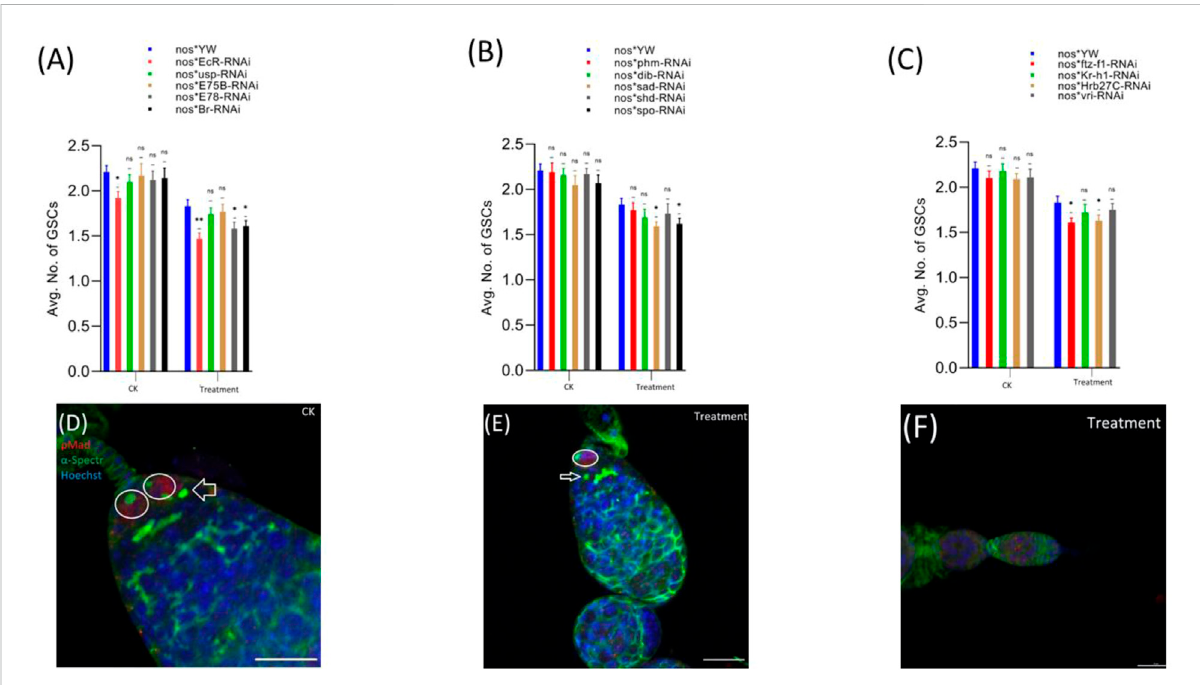
FIGURE 3 Effect of cyromazine on the GSCs of adult ovaries. (A) RNAi of ecdysone-responsive primary genes and the effect of cyromazine on the GSCs. (B) RNAiofHalloweengenesandtheeffectofcyromazineontheGSCs. (C) RNAiofecdysone-responsivegenesandtheeffectofcyromazine onthe GSCs. CK means that the fl ies were fed on a normal diet, while treatment means the fl ies were fed insecticide containing diet. (D) The adult ovariole fromtheCK group.White circleindicatesGSCs,whilewhite arrowrepresentsCBs. (E) Onlyone GSCsandone CBispresentinthecyromazine- treated ovariole. (F) The ovariole lacking any GSC in the germarium (scale bar, 10 μ m (D,E) , 25 μ m (F) ). For the t -test: * p < 0.05; ** p < 0.01; *** p < 0.001; ns indicates not signi fi cant ( p >